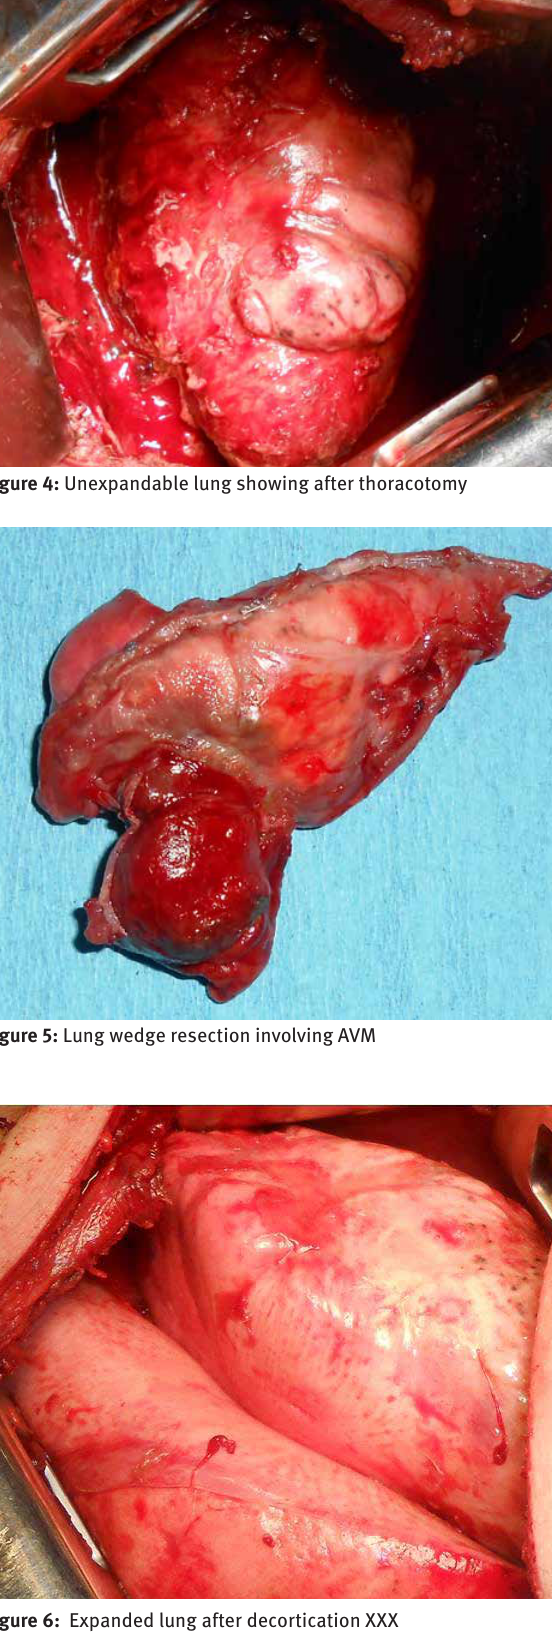
Figure 6: Expanded lung after decortication